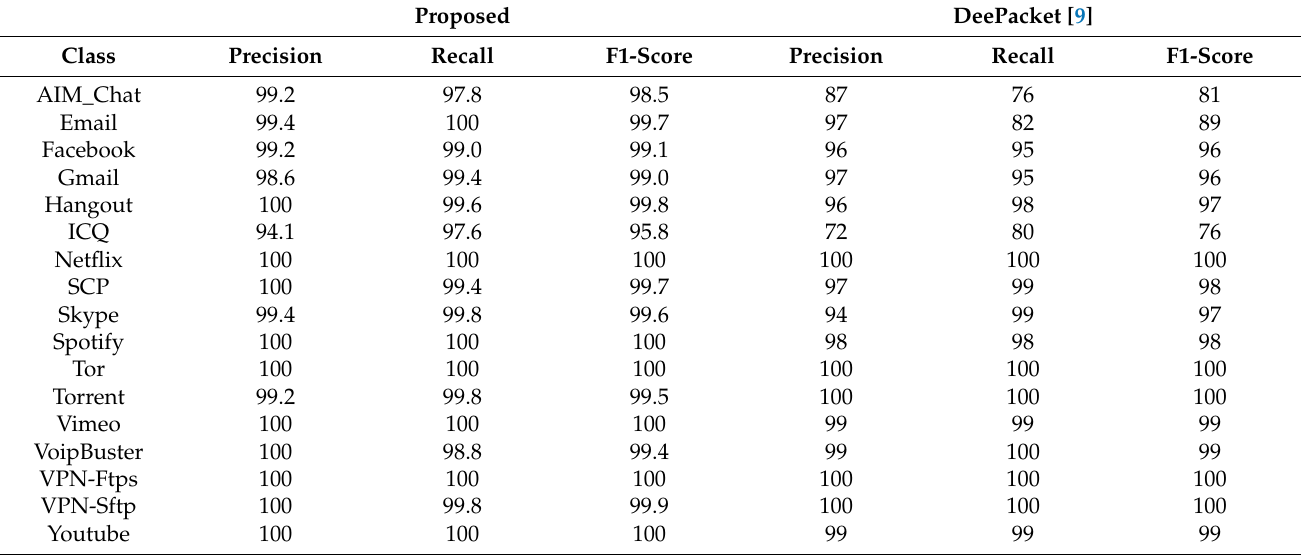
Table 9. Performance for each type of encrypted traffic application